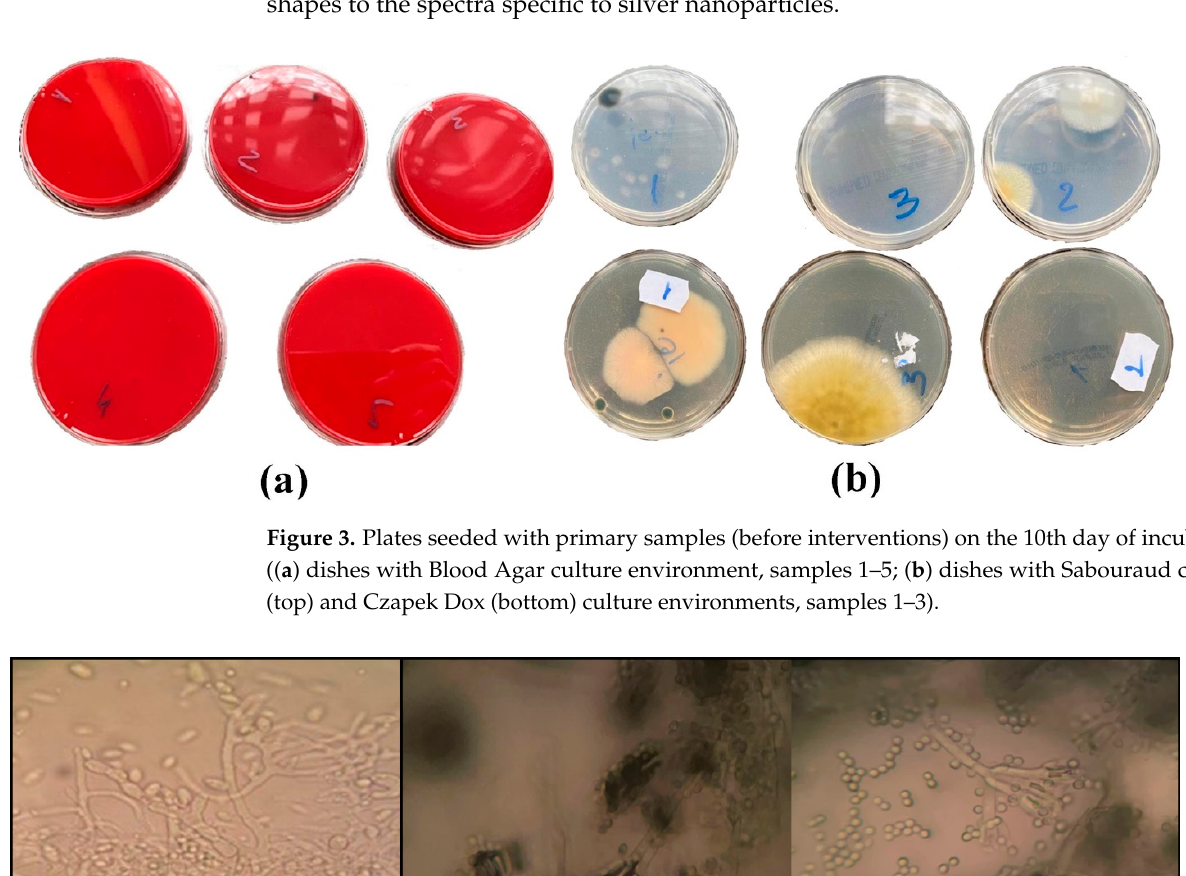
Figure 4. Microscopical aspects sample (( a ) Cladosporium spp.; ( b ) Penicillium spp.).